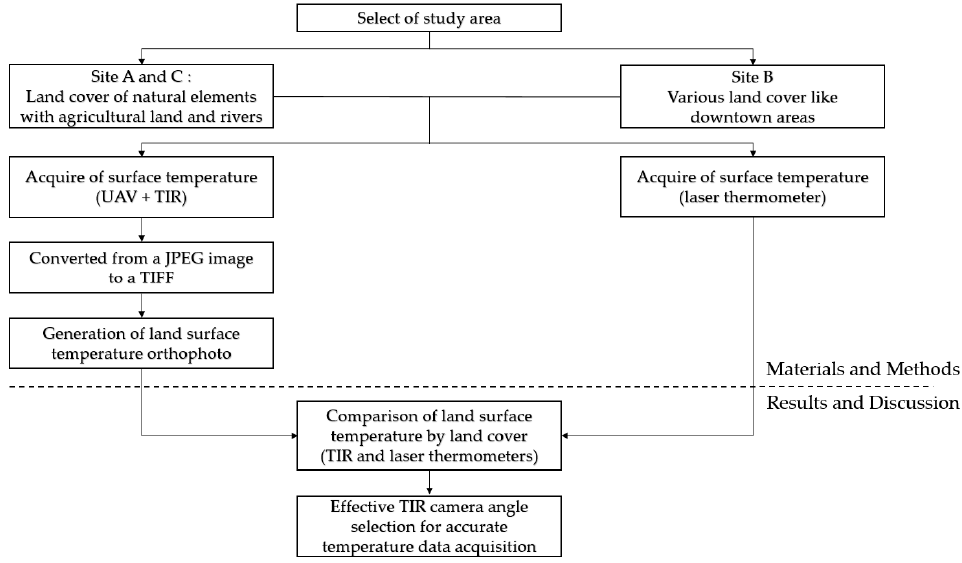
Figure 1. Overall study flow chart (Site A : plants, trees and river; Site B : Kyungpook National University Sangju Campus; Site C : farmland and